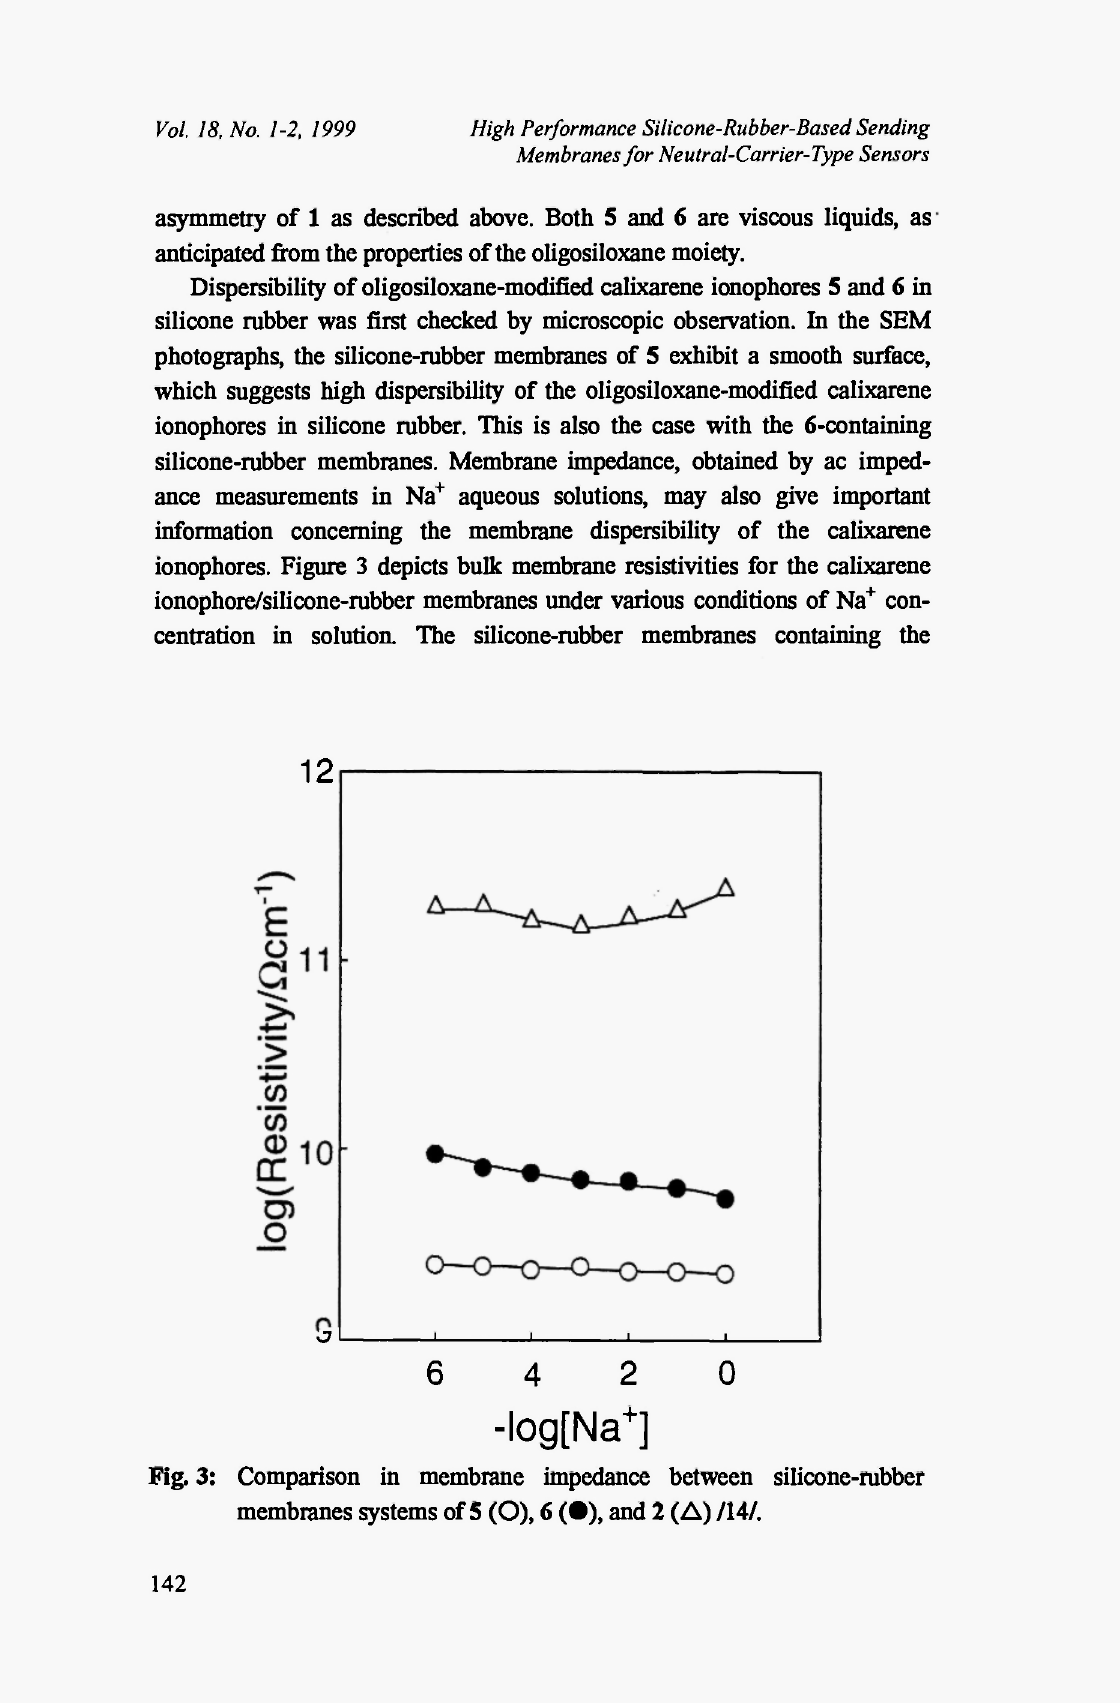
Fig. 3: Comparison in membrane impedance between silicone-rubber membranes systems of 5 (O), 6 ( · ), and 2 (Δ)